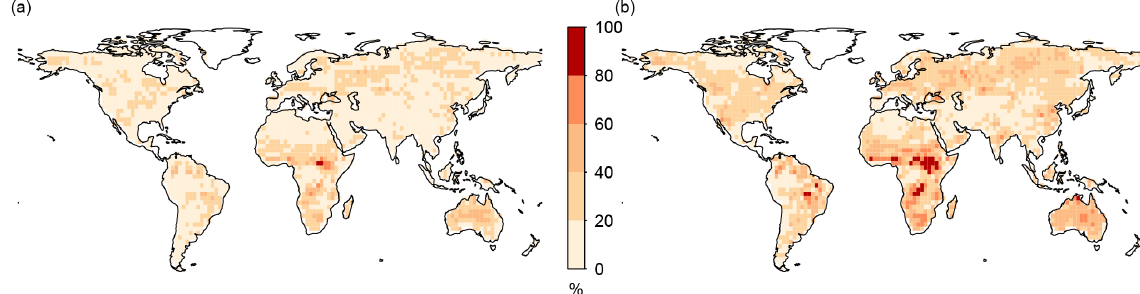
Figure 5. Fraction of models for which UQM increases biases (a) or does not decrease biases by more than 50% in the 90th percentile of WBGT (b)